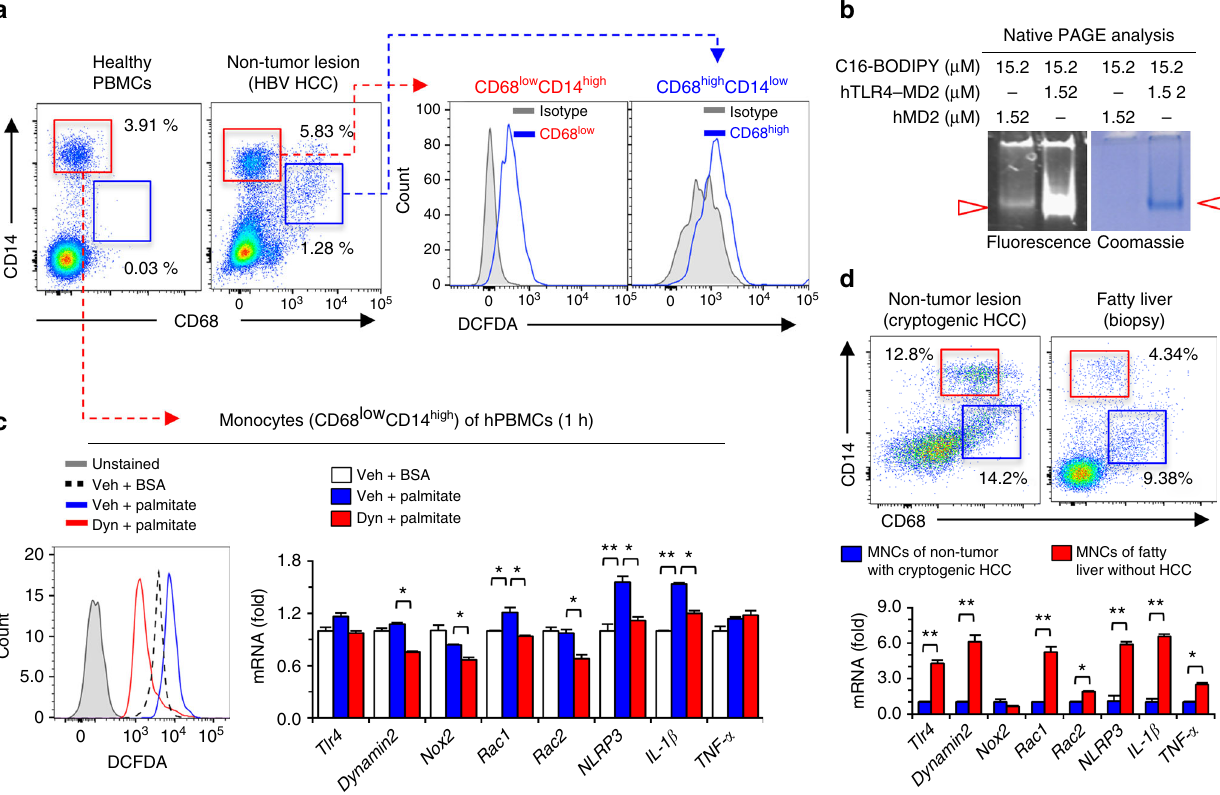
Fig. 7 Palmitate treatment increases ROS generation in human CD68 low CD14 high monocytes via endocytosis of palmitate/TLR4 complex. a Healthy human peripheral blood mononuclear cells (PBMCs) and isolated liver mononuclear cells (MNCs) from non-tumor lesions of HCC (HBV origin) were subjected to fl ow cytometry and assessment of ROS generation, respectively. b After the reaction between each protein and BODIPY-labeled fl uorescent fatty acid analog (C16-BODIPY) under the indicated conditions, the samples loaded at Native gradient PAGE (4 – 15%) were visualized with illumination (488 nm) and Coomassie staining. c Healthy human PBMCs were treated with palmitate ± dynasore. Then, these cells were subjected to assessment of ROS generation and qRT – PCR analyses. d Freshly isolated liver MNCs from non-tumor liver lesions of primary HCC and biopsy lesions of fatty liver were subjected to fl ow cytometry and qRT – PCR analyses. Data are representative of three independent experiments using PBMC of healthy controls ( n = 5) and liver MNCs of HBV ( n = 3), cryptogenic HCC ( n = 1) and fatty liver ( n = 1) patients a , c , d . Data are expressed as the mean ± s.e.m. and analyzed by Student ’ s t -test or one-way analysis of variance, * P < 0.05, ** P < 0.01 in comparison with the corresponding (Supplementary Fig. 8b, c). WT NOX2 and NOX2 NOX2 mice had improved glucose tolerance as assessed by GTT (Fig. 8a) and lower serum ALT and TC, as compared to WT NOX2 and NOX2 NOX2 mice (Supplementary Fig. 8d). The livers of WT NOX2